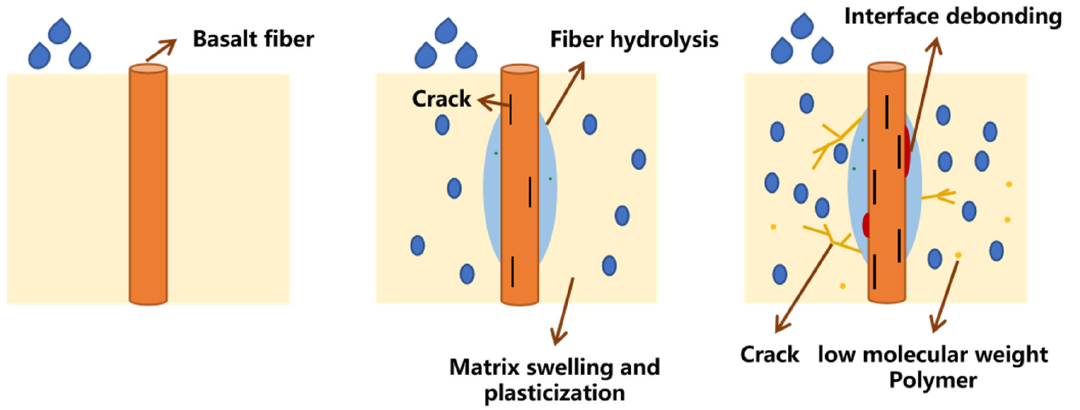
Figure 19. Moisture absorption mechanism of BFRPs.